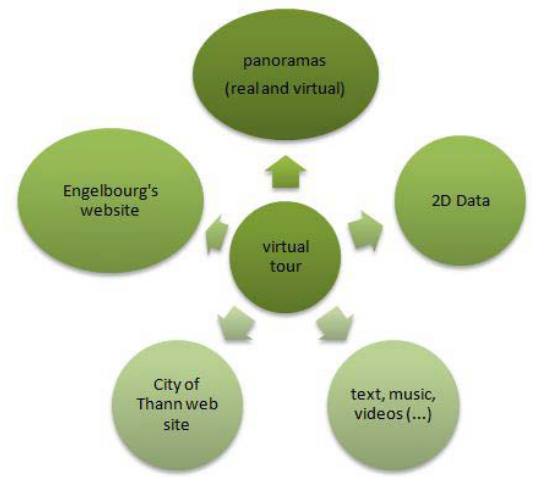
Figure 5. Links between virtual tour and external